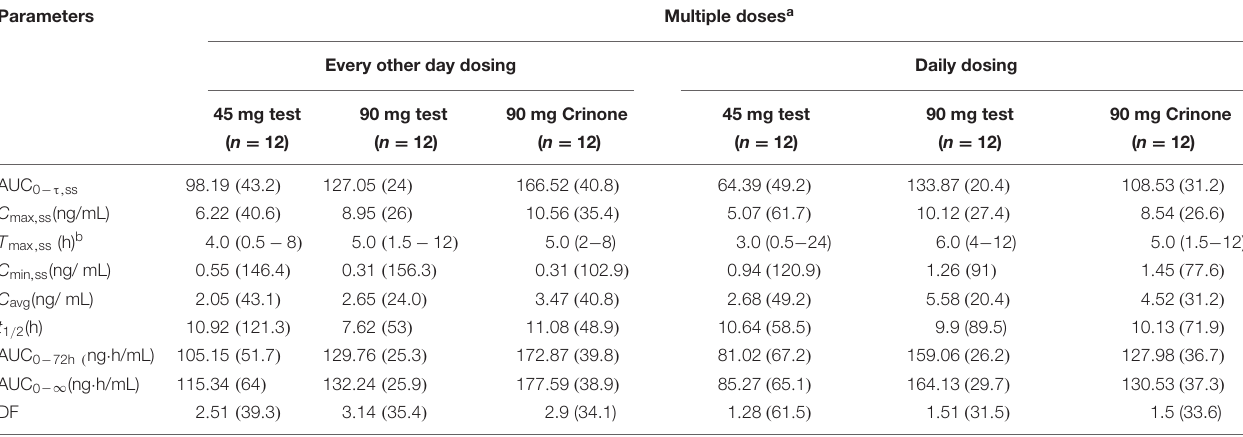
TABLE 5 | Pharmacokinetic parameters of progesterone at the steady-state after administration three formulations of vaginal progesterone gel. Parameters Multiple doses